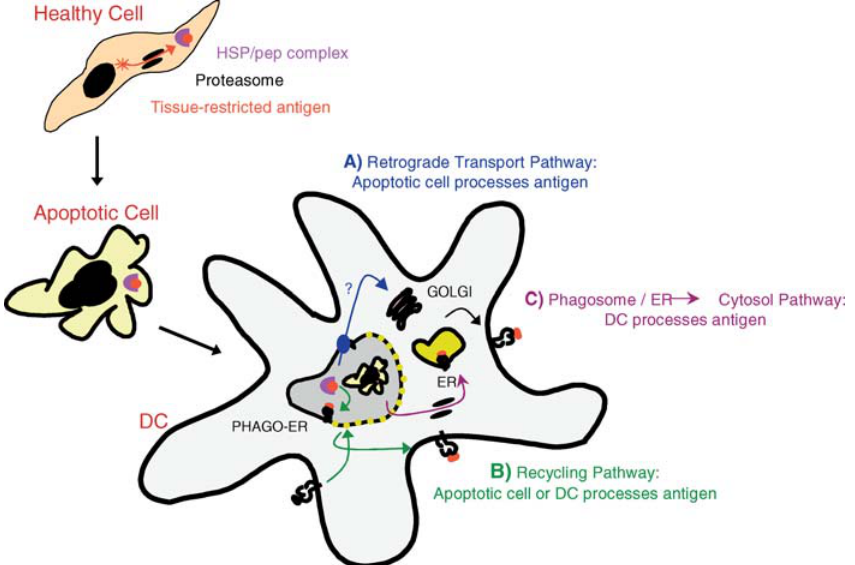
Figure 6. An Active Role for Apoptotic Cells in the Transfer of Antigen to DCs We propose that apoptotic cells play an active role through the transfer of processed antigen to DCs for the generation of MHC I/pep complexes. This pathway may be dominant in the presentation of infectious antigen as the virus may co-opt cellular translational machinery, resulting in high levels of viral protein, and the upregulation of stress proteins, as well as inducing apoptotic cell death. Defective ribosomal initiation products chaperoned by HSPs offer a potential source of antigen. Within the DC, HSPs derived from the internalized apoptotic cell may traffic via a retrograde transport pathway, shuttled to the trans -Golgi and then the ER via binding to KDEL receptors (A). Alternatively, the evidence for phagosome–ER (PHAGO-ER) fusion and/or the recycling of MHC I from the plasma membrane offers the possibility that processed antigen may interact directly with the DC’s MHC I (B). As ER chaperones within the phagocytosed cell would be bound to the pool of peptides derived from newly synthesized proteins, these pathways offer the DC an accurate representation of what occurred immediately prior to death (A and B). At high concentrations of protein, we also find evidence for the DC processing the cross-presented antigen. This likely occurs via a phago–ER-to- cytosol pathway as has been previously described